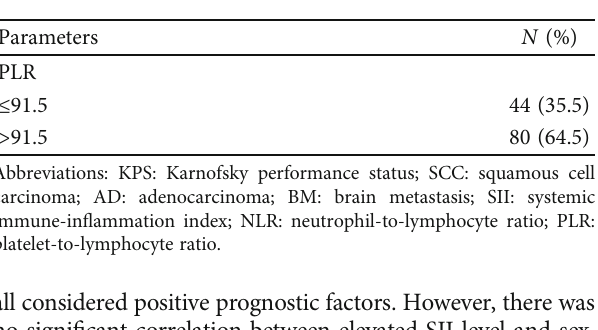
Table 3. Age ( P = 0 : 002 ), smoking history ( P = 0 : 014 ), KPS ( P = 0 : 021 ), primary AJCC stage ( P = 0 : 045 ), and SII